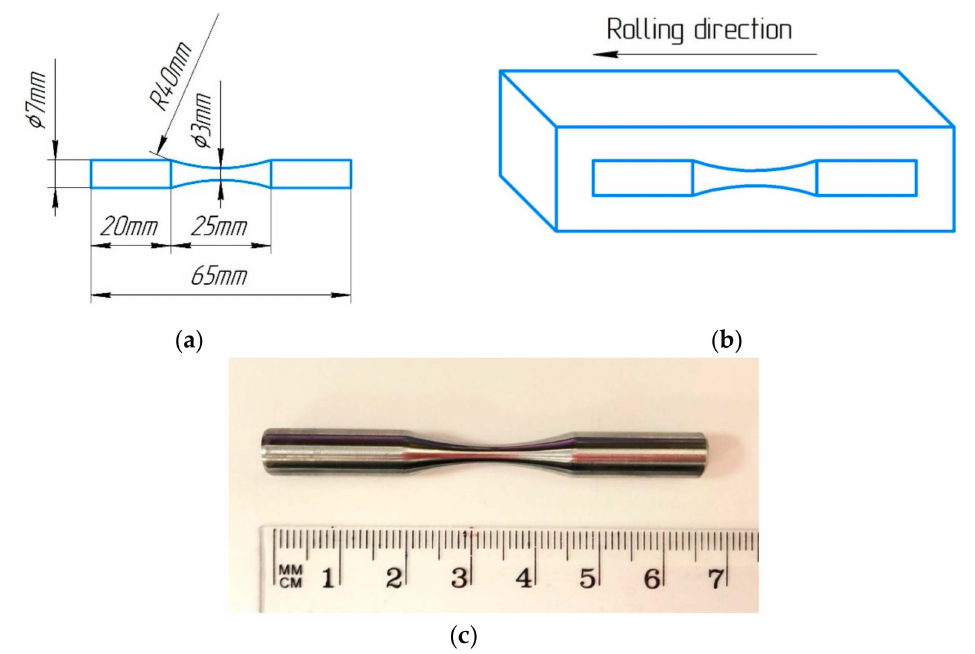
Figure 3. ( a ) Drawing of the fatigue test sample, ( b ) scheme of cutting samples for fatigue testing from CR specimens, and ( c ) photo of specimen for fatigue